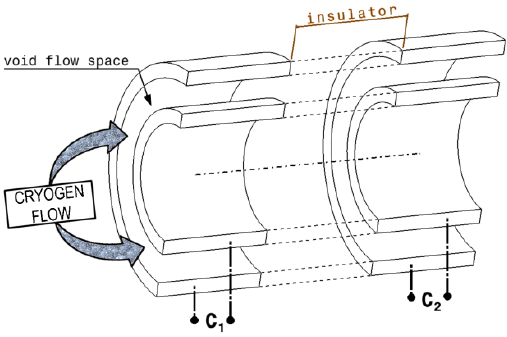
Figure 1. Schematic view of a capacity type flow meter.